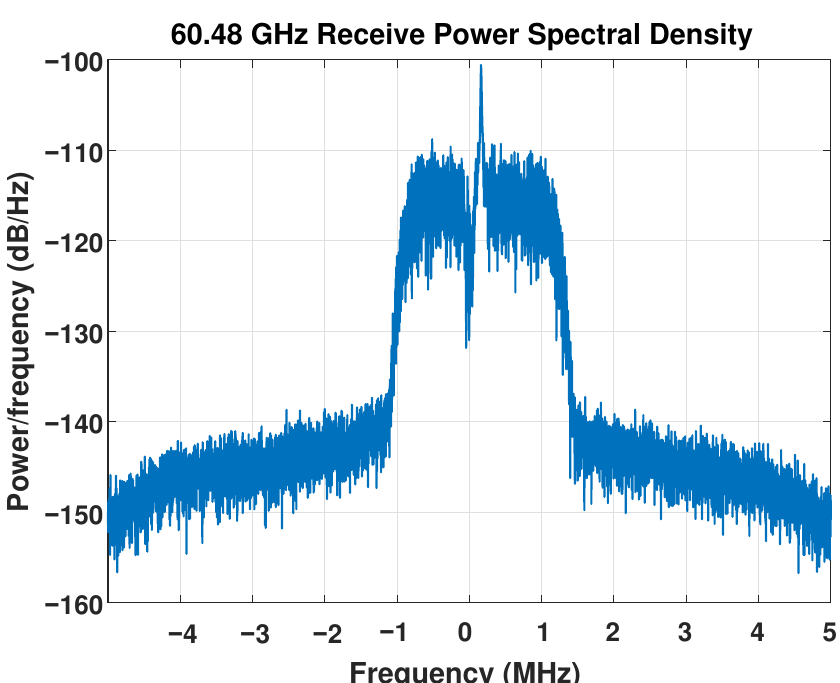
Figure 15. Snapshot of the over-the-air, received power spectral density in the WiGig Channel 2 band at 60.48 GHz.